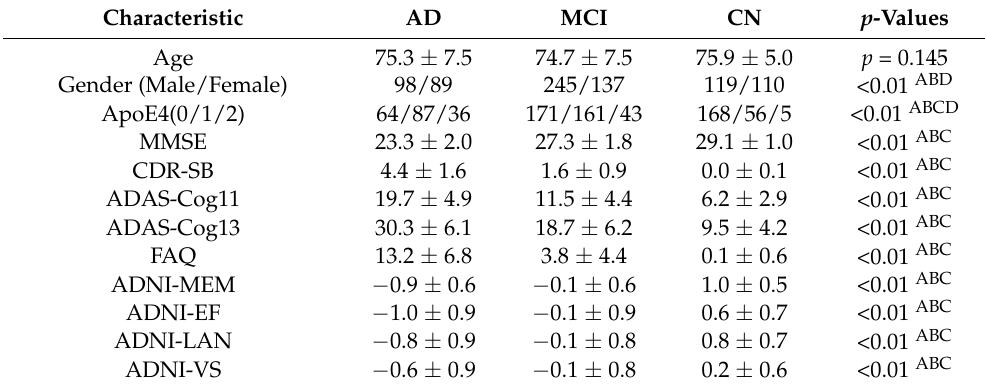
Table 1. Demographic information and neuropsychological assessment results of the subjects in ADNI. Characteristic AD